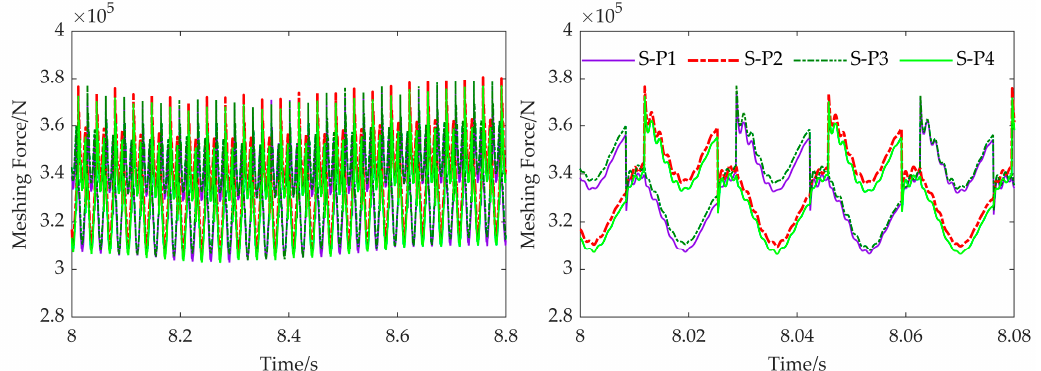
Figure 11. Meshing force between the sun and the four planet gears of the LSP.